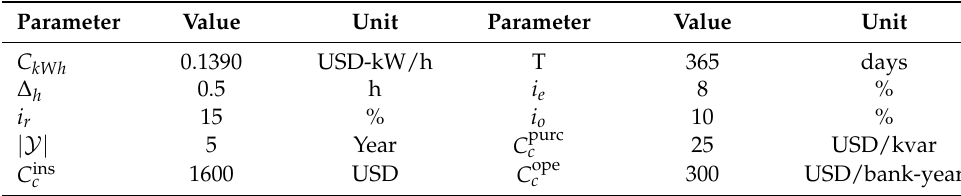
Table 2. Parametric information to evaluate the objective